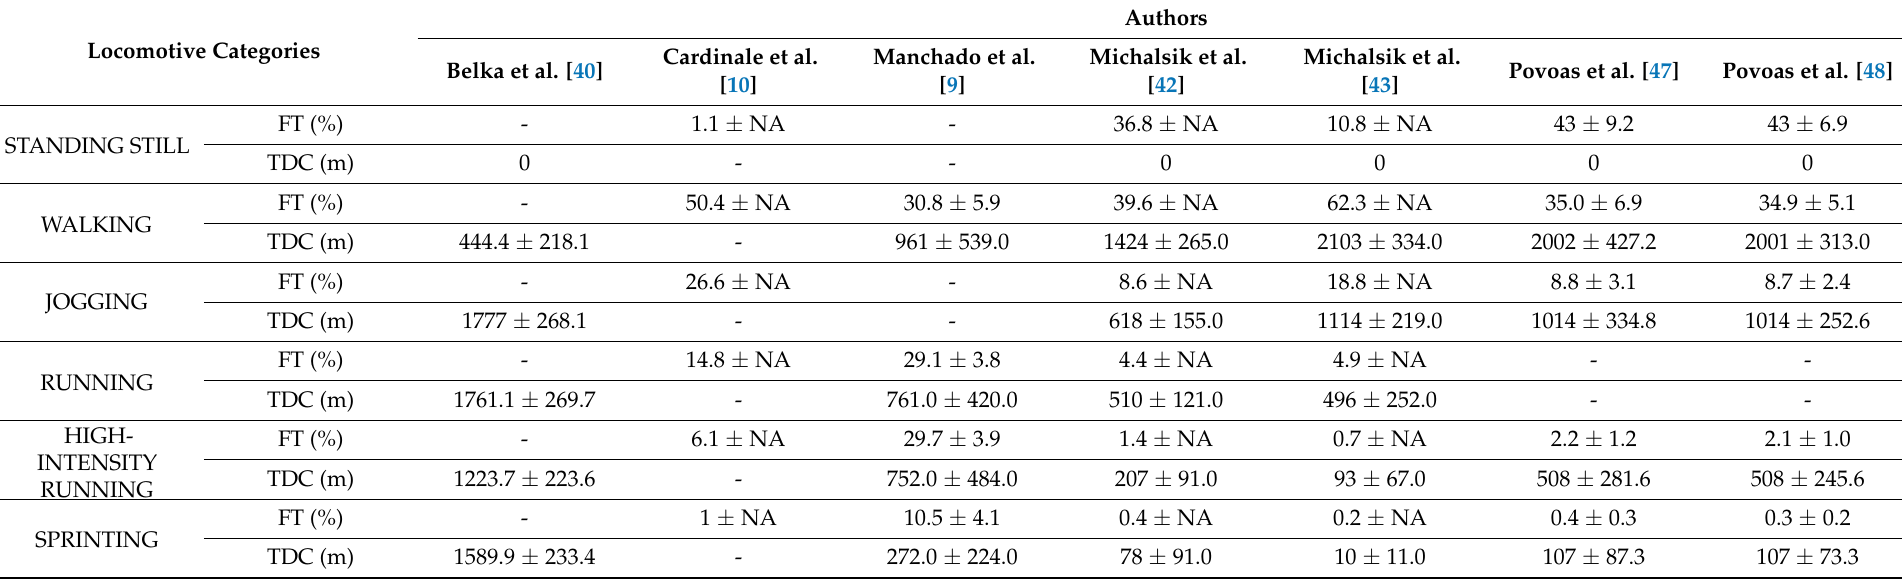
Table 3. External load variables based on time–motion